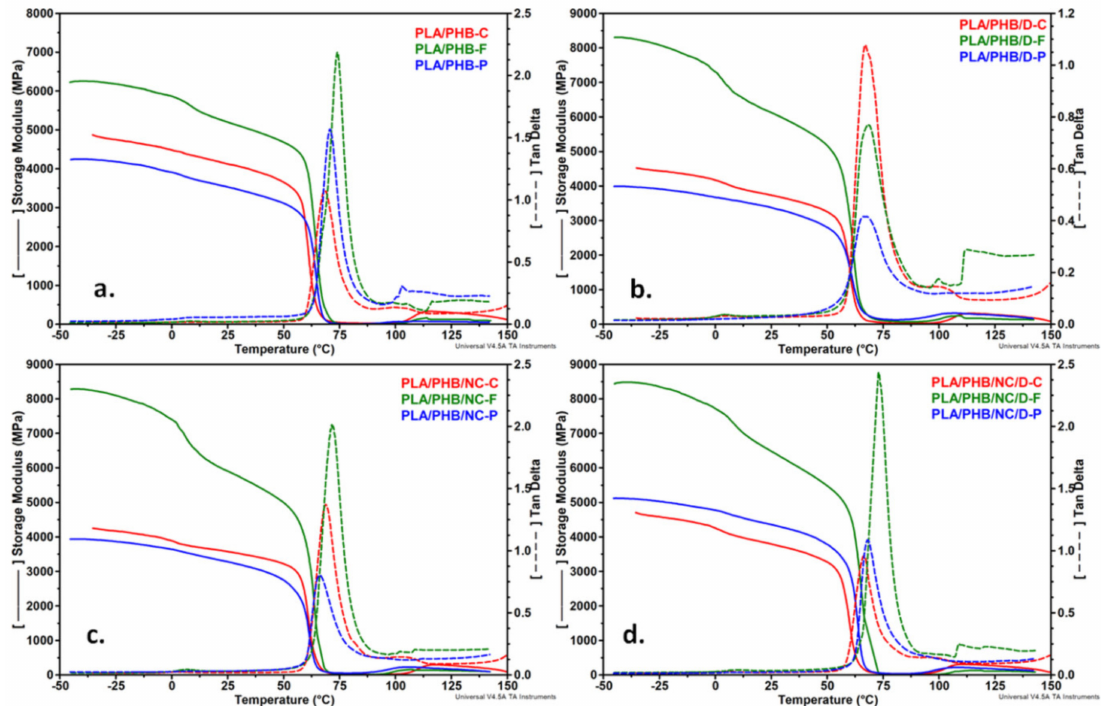
Figure 10. Storage modulus and tan δ plots for the PLA / PHB blends ( a , b ) and nanocomposites ( c , d ) as films, filaments and printed